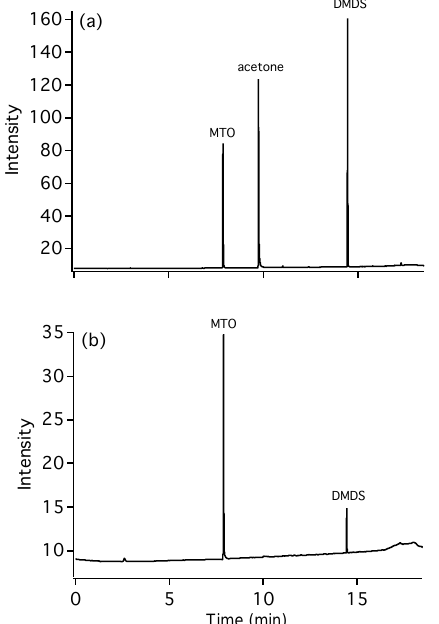
Figure 6. GC-FID chromatograms from the analysis of a glass sam- pling vessel containing pure MTO standard mixtures prepared in the laboratory. Analyses were performed via (a) the conventional pre-concentration method ([MTO] = 1.80ppm) and (b) via a fast injection method ([MTO] =